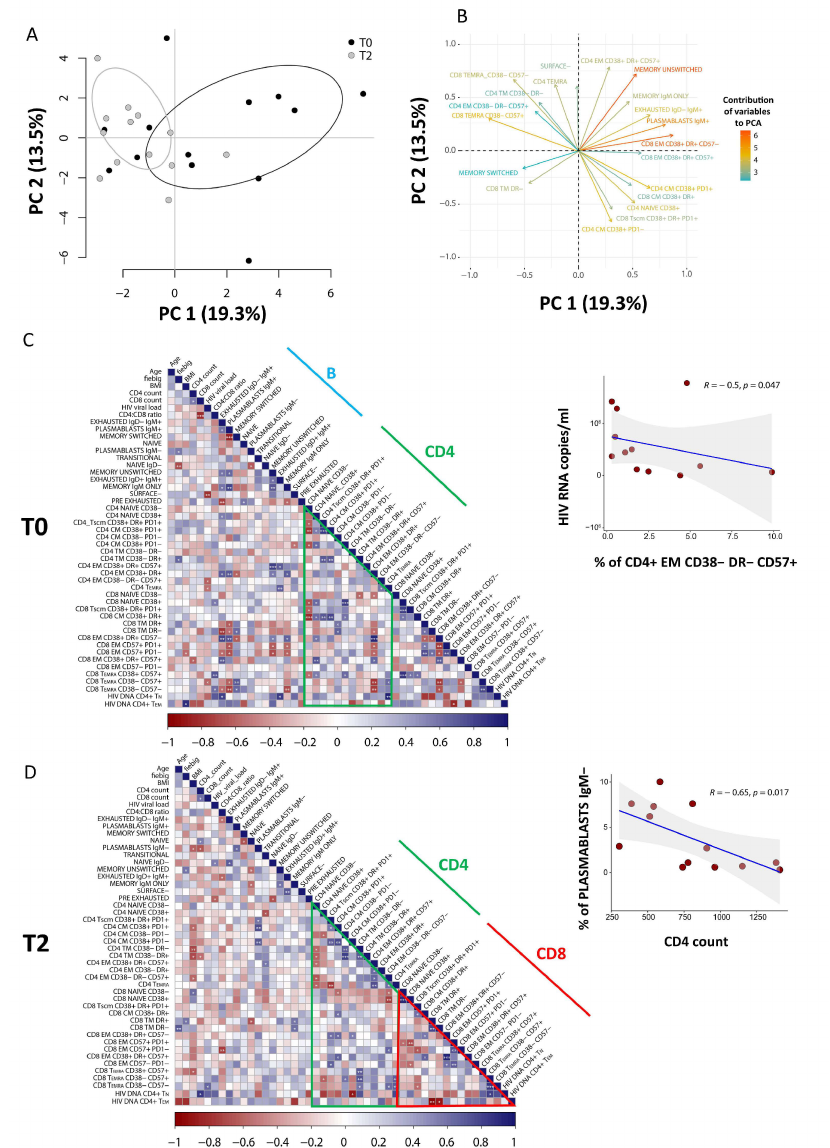
Figure 5. Contribution of different variables and correlations between clinical and immunological data. ( A ) Principal component analysis (PCA) of patients performed using T and B frequencies at T0 (n = 13) and T2 (n = 13), as obtained from high-dimensional data analysis. ( B ) Weight of the first 20 most important variables that contribute to PCA. Positively correlated variables point to the same side of the plot, whilst negatively correlated variables point to opposite sides of the graph. ( C , D ) Correlograms of patients before starting (T0) and after 12 months of ART (T2). Percentage of B and T clusters, intracellular HIV-DNA content and clinical parameters were used to perform the analysis. Spearman rank correlation values (r) are shown from red ( − 1.0) to blue (1.0); not-ordered r values are indicated by the color intensity of the square. Blank square indicates lack of signal; p-values are indicated by white asterisks ( ∗ p < 0.05, ∗∗ p < 0.01, ∗∗∗ p < 0.001). The Figure also shows the correlation of EM CD38 − DR − CD57+ (indicated as percentage of total CD4+ T cells) with plasmatic viral load (copies/ml) at diagnosis (T0) and the correlation of IgM- plasmablasts (indicated as percentage of total CD19+ B cells) with the absolute count of CD4+ T cells after 12 months of